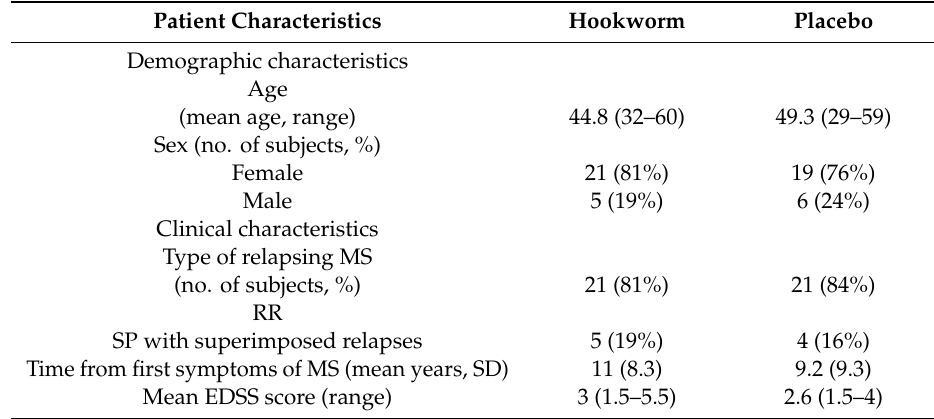
Table 1. Demographics and baseline clinical features of hookworm-treated ( n = 26) and placebo-controlled ( n = 25) PwMS.